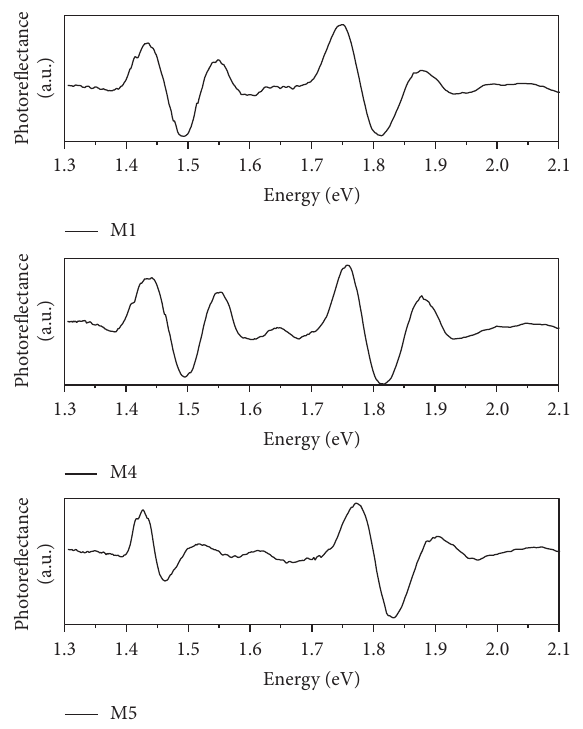
Figure 7: PR spectra of M1, M4, and M5 heterostructures passivated with 0, 1, and 2 silicon monolayers, respectively. The 375 nm laser was used as modulation source.